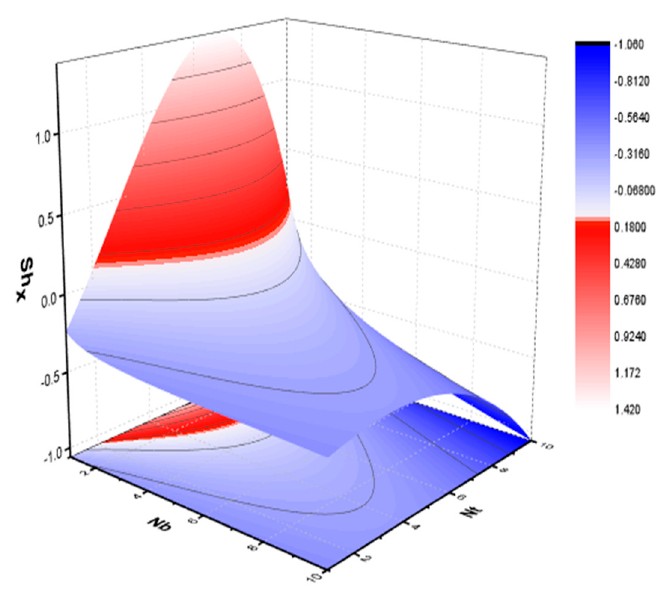
Figure 25. 3D visual of Sh x for Nb and